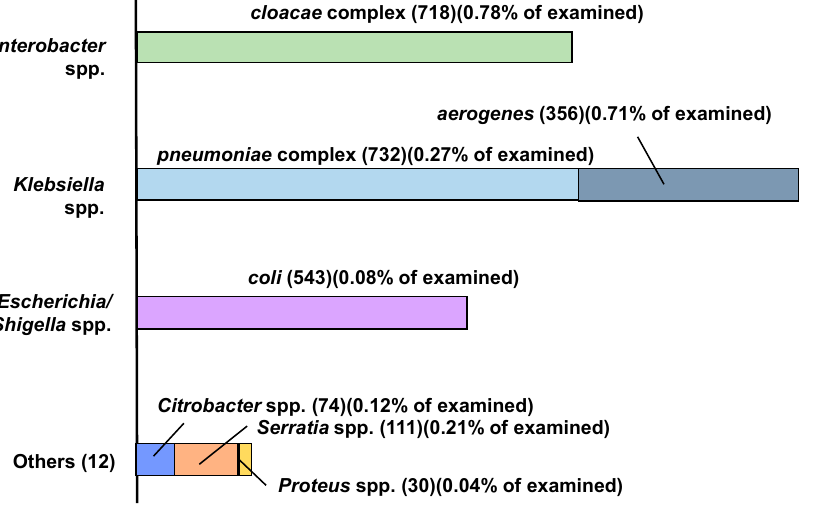
Figure 5. The number of meropenem-resistant Enterobacterales cases reported to JANIS in 2020. Both results on inpatients and outpatients were totaled.